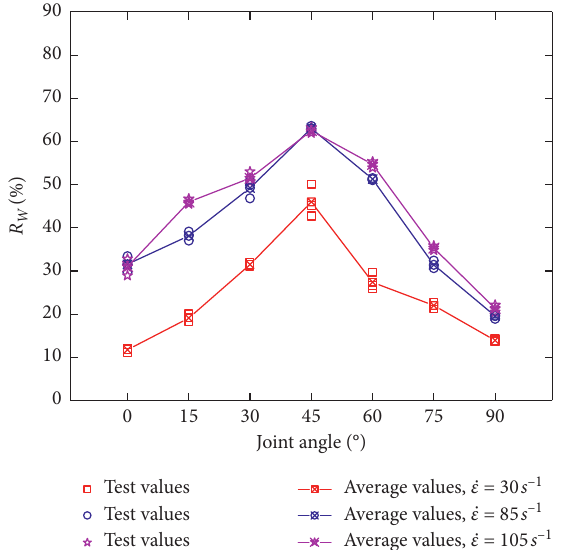
Figure 12: Variation in R strain rates.